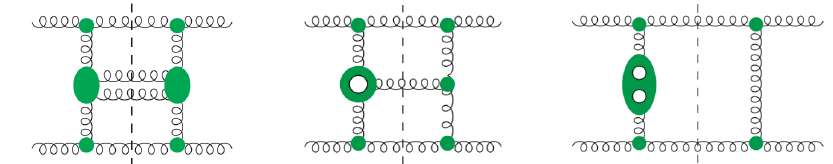
Figure 4 . ( a ) Tree six-gluon amplitude. The oval blob represents the central-emission vertex — the emission of two gluons or of a quark-antiquark pair along the gluon ladder. ( b ) One-loop five-gluon amplitude. The pierced blob represents the one-loop corrections to the central-emission vertex. ( c ) Regge trajectory in the two-loop four-gluon amplitude. The double pierced oval represents the two-loop Regge